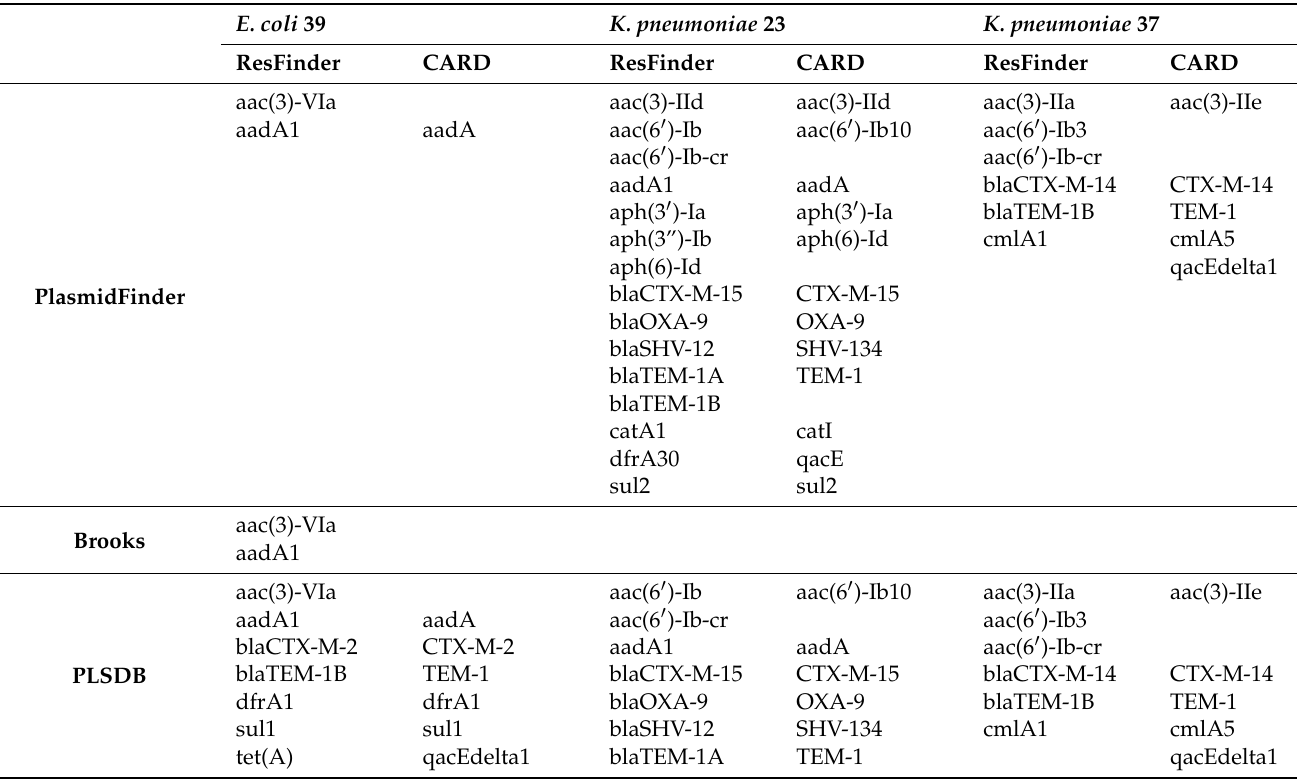
Table 7. Predicted ARG plasmid using hybrid assembled data for both E. coli and K. pneumoniae